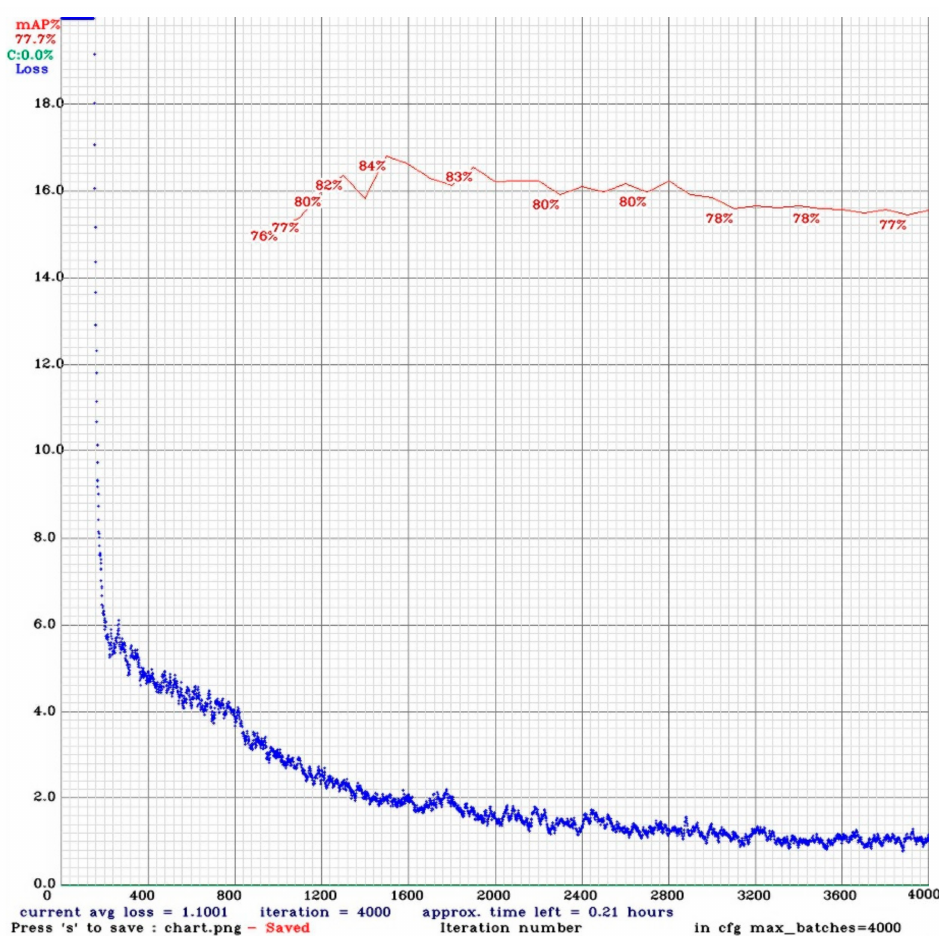
Figure 6. Outputs obtained YOLOv4 running 4000 epochs using 720 × 720